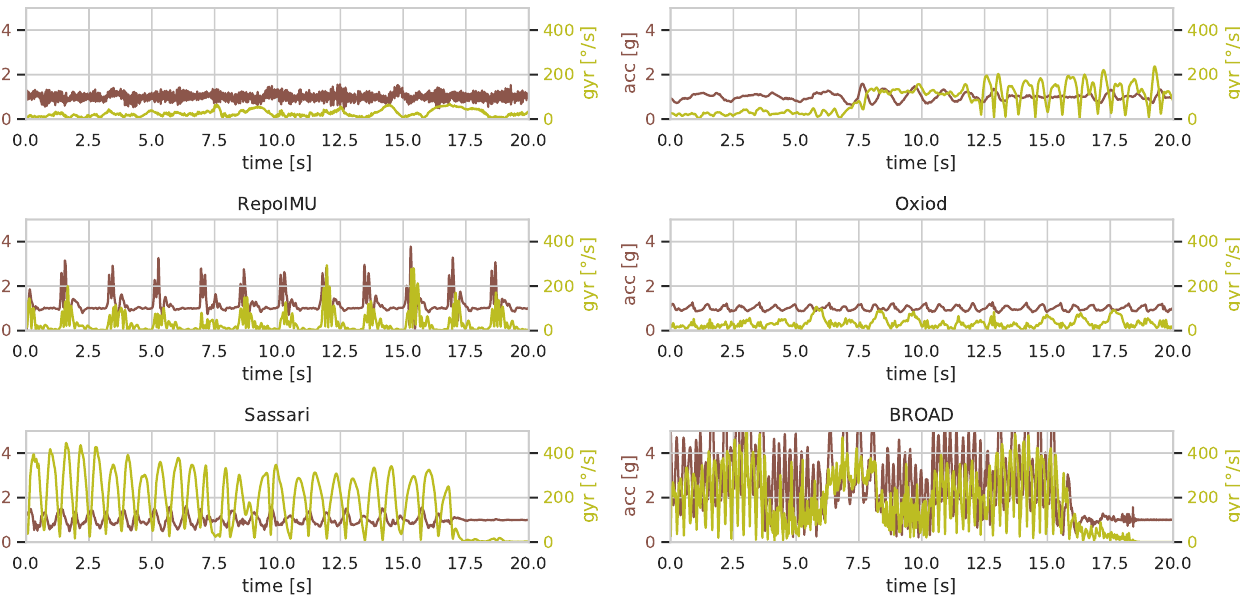
Figure 4. Raw signal magnitudes over time for exemplary sequences from all six datasets. Rotational and translational characteristics vary